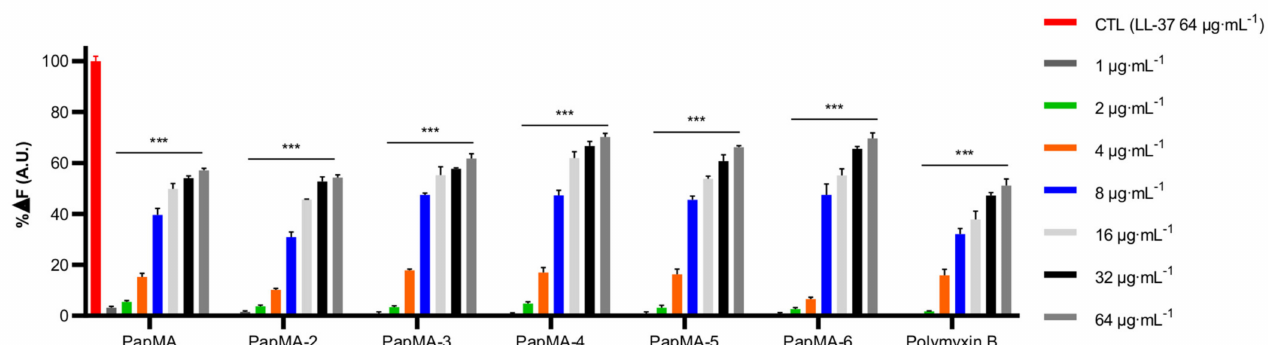
Figure 2. LPS interaction of PapMA analogs. Binding affinity of PapMA derivatives and polymyxin B to LPS based on displacement assays with BODIPY-TR-cadaverine fluorescent dye. Statistical analysis was performed using two-way ANOVA with Dunnett’s comparison test. The values are expressed as the mean ± SEM of three independent experiments and are statistically significant at *** p < 0.001; ns, not